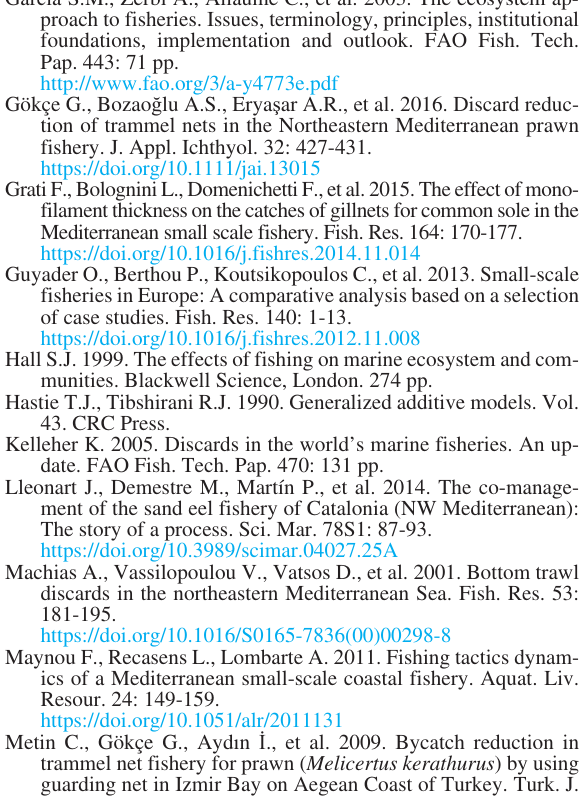
Table S1. – Taxonomic list of the species caught, with density and biomass indices according to the three types of net. STN, stand- ard trammel net; TGN20, standard trammel net with guarding net of 19 cm; TGN25, standard trammel net with guarding net of 24 cm. Cat, commercial category (C, commercial; NC, non commercial; H, habitat; B, benthic; D, demersal or nektoben- thic; P,